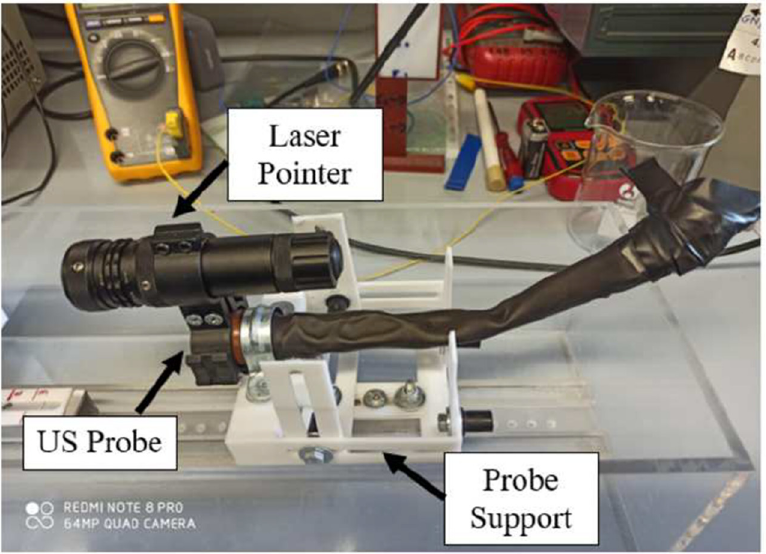
Figure 2. The picture shows the detail of the guide on which the probe can be moved, attached to the laser pointer, to move at different focal distances according to the frequency.